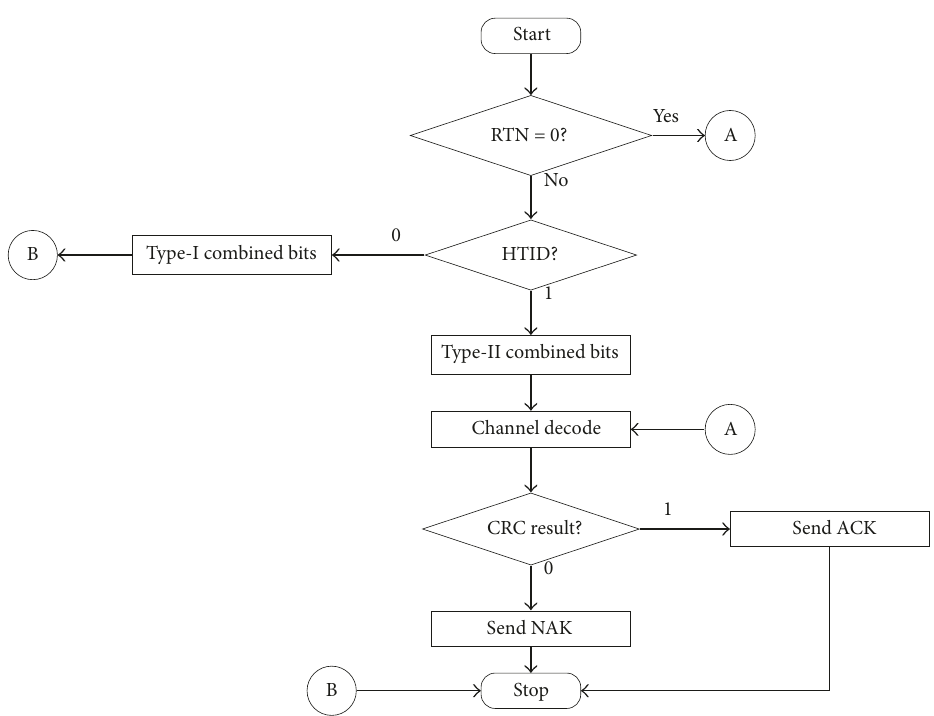
Figure 20: Flowchart showing the slave mode of operation for the HARQ control algorithm. HTID: HARQ type identifier, MCS: Modulation and Coding Scheme, RTN: ReTransmission Number, and CRC: Cyclic Redundancy Check.